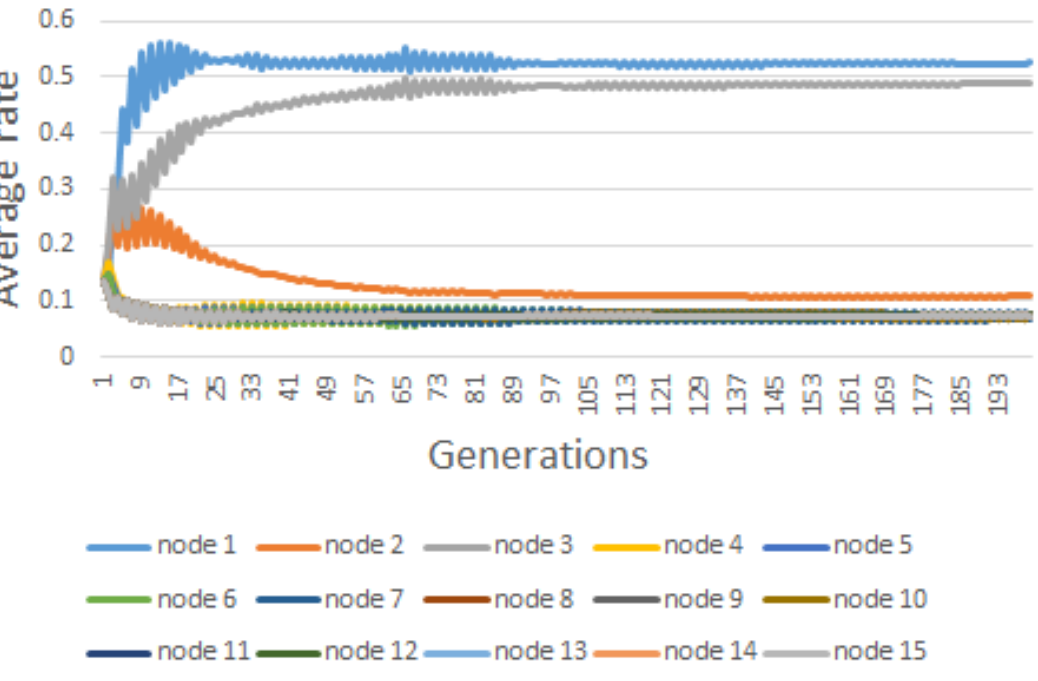
Figure 6. Evolution graphs for average attack for the nodes of the case study. The defender’s budget equals to 2.0. The x-axis presents the generations. The y-axis presents the evolution of average rates.